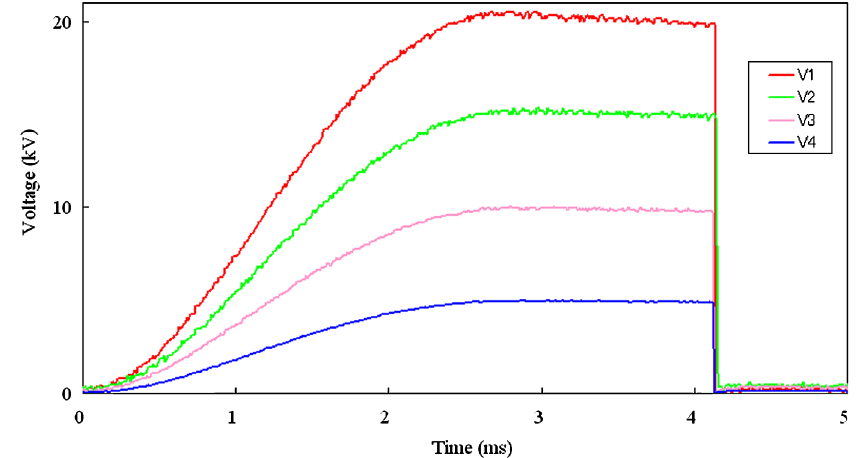
FIG. 21. Voltage waveforms measured at kicker electrodes. Voltages V1–V4 correspond to the voltages at the anode and the subsidiary electrodes S1–S3, respectively.